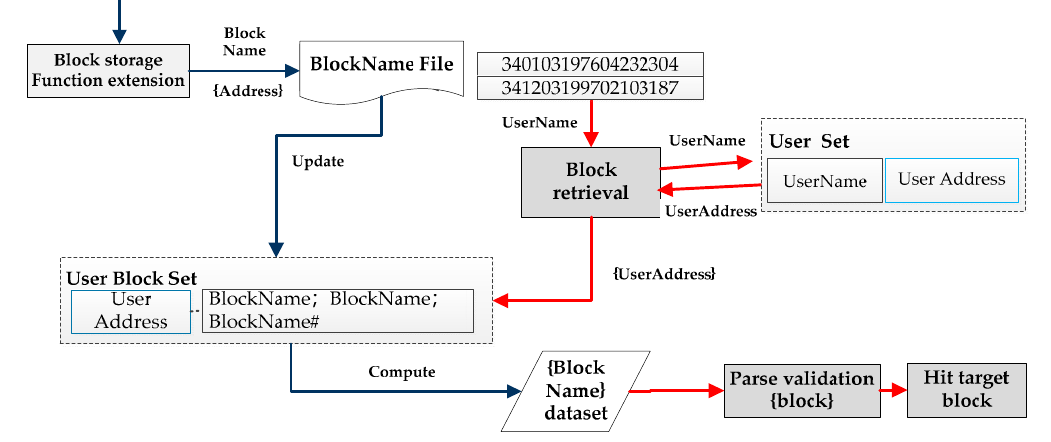
Figure 11. The block retrieval method with “User Block